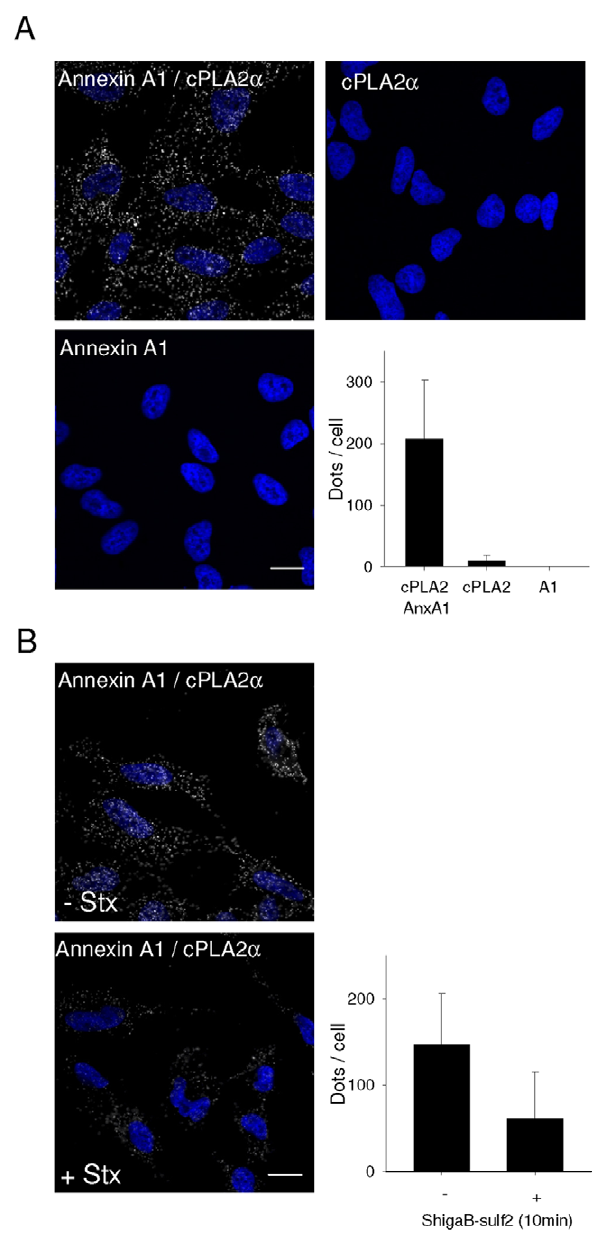
Figure 5. Close proximity of Annexin A1 and cPLA2 a in HeLa cells. (A) Close proximity of annexin A1 with cPLA 2 a was evaluated using proximity ligation assay from Duolink. Fixed and permeabilized cells were incubated with the indicated primary antibodies by pair or alone as negative control. Scale bar is 20 m m. Dots per cell were automatically counted using ImageJ software and the data presented in the diagram is the average of at least 40 cells per condition in one representative experiment (n=3), error bars indicating standard deviation. Values for negative controls were 10.3 6 2.7 and 0.3 6 0.1 dots per cell for cPLA 2 a and annexin A1 antibodies respectively. (B) Before proximity ligation assay, cells were washed and incubated for 30 min in Hepes buffered medium. They were subsequently incubated for 10 min with ShigaB before staining with annexin A1 and cPLA 2 a antibodies in combination. Scale bar is 20 m m. Interaction events where evaluated as in A. Data presented are the average of at least 40 cells quantified per condition for one representative experiment (n=3), error bars indicating standard deviation.